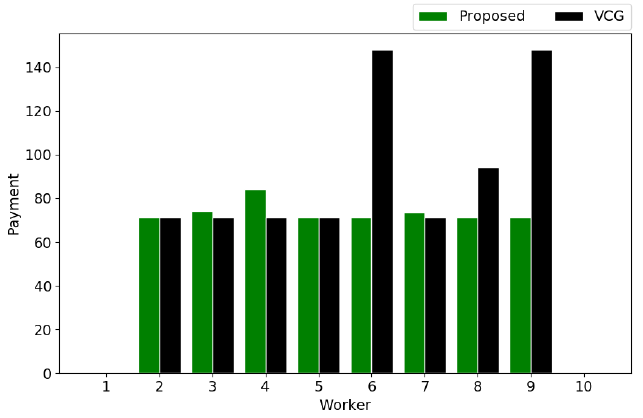
Figure 9. Payments to